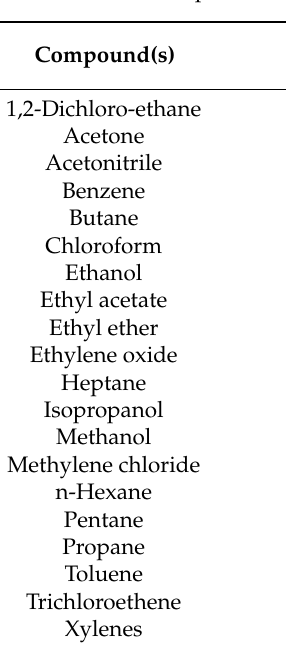
Table 2. Analytes and their limit of detection (LOD), limit of quantification (LOQ), and action limits for levels in cannabis